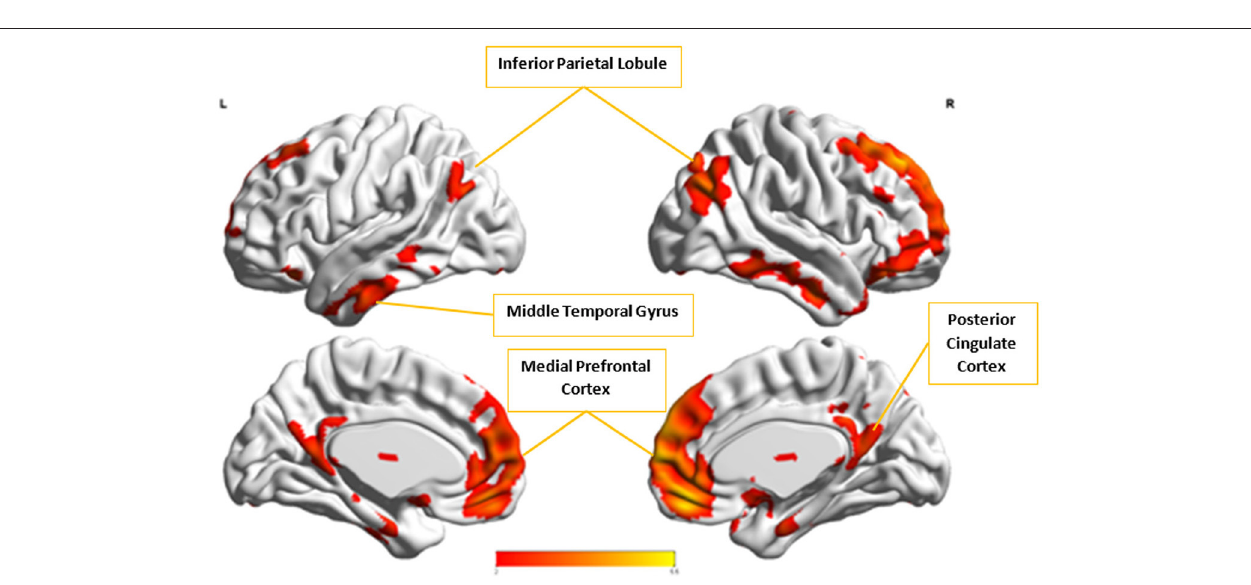
FIGURE 11 | This figure represents the spatial map for A x c , the group-level component in the Autism group with the highest spatial correlation with C x . These regions represent the default mode network (DMN).